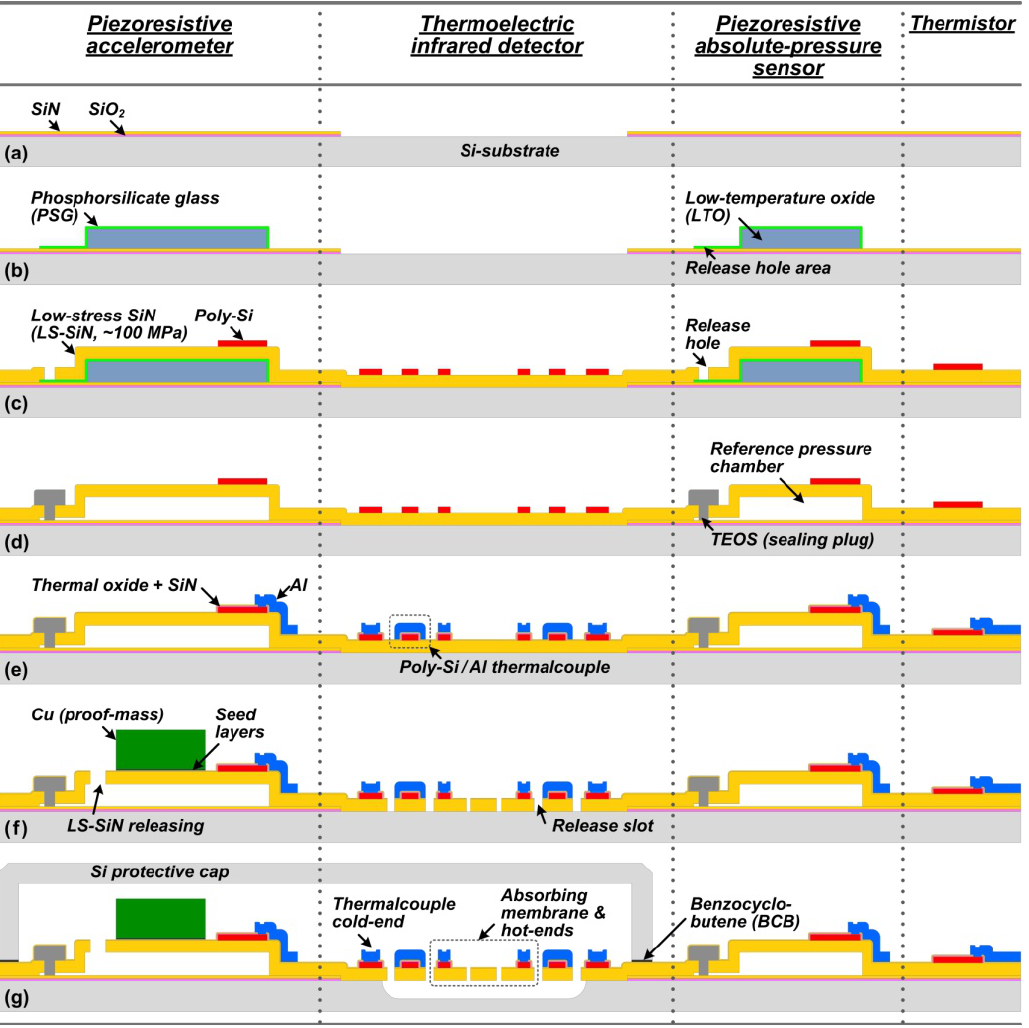
Figure 3. The developed single-side-integrated process flow for the prototype PATIR composite